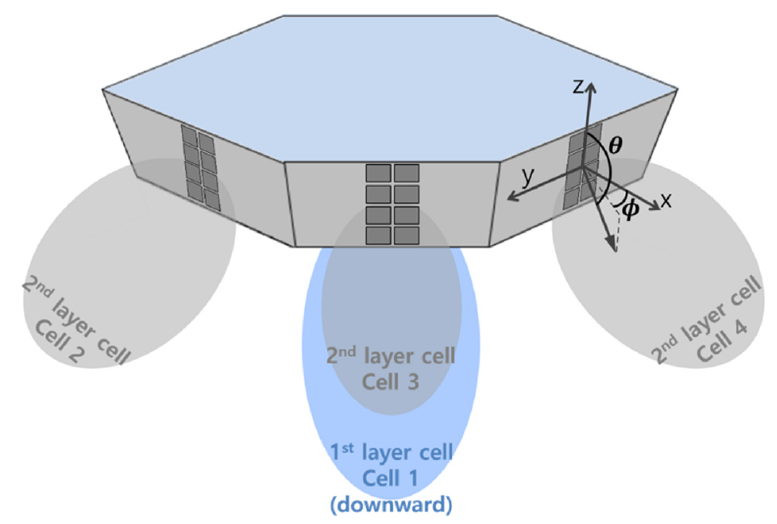
Figure 3. Typical antenna structure for multi-cell HAPS communication.